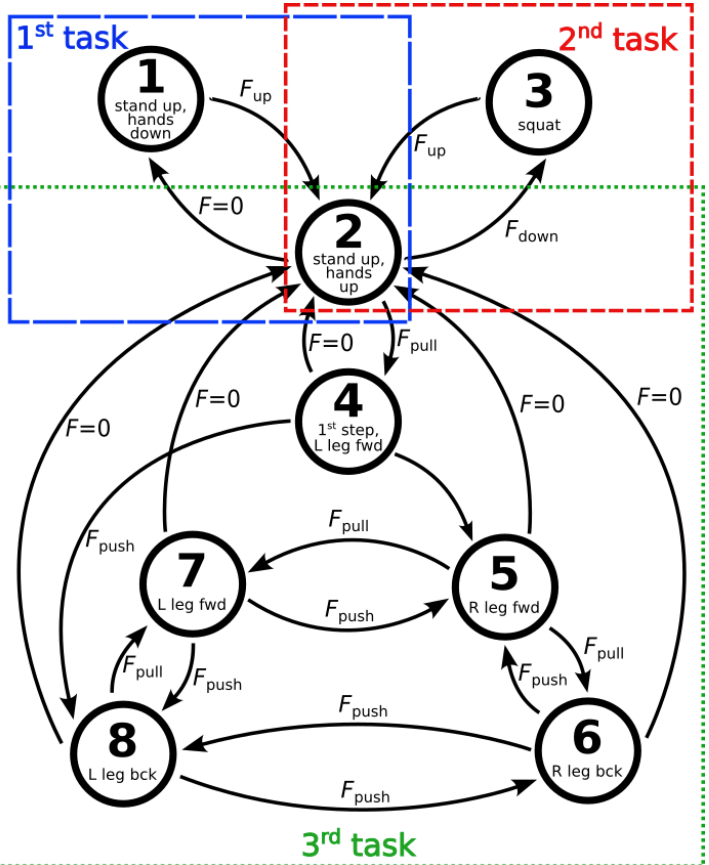
Figure 4. A schematic representation of the dynamical PSS consisting of 8 states, guided by the SHC networks, with the corresponding positions of the humanoid robot and the conditions for the transitions between the PSS states to occur. The numbered circles represent the PSS states with the corresponding humanoid robot positions. The arrows between the circles represent the possible PSS transitions, while the forces next to the arrows are the conditions that trigger the corresponding transition. The blue (dashed), red (finely dashed), and green (dotted) rectangles encompass the PSS states, the transitions between them, and the configurations of the humanoid robot for the first, second, and third motion task,